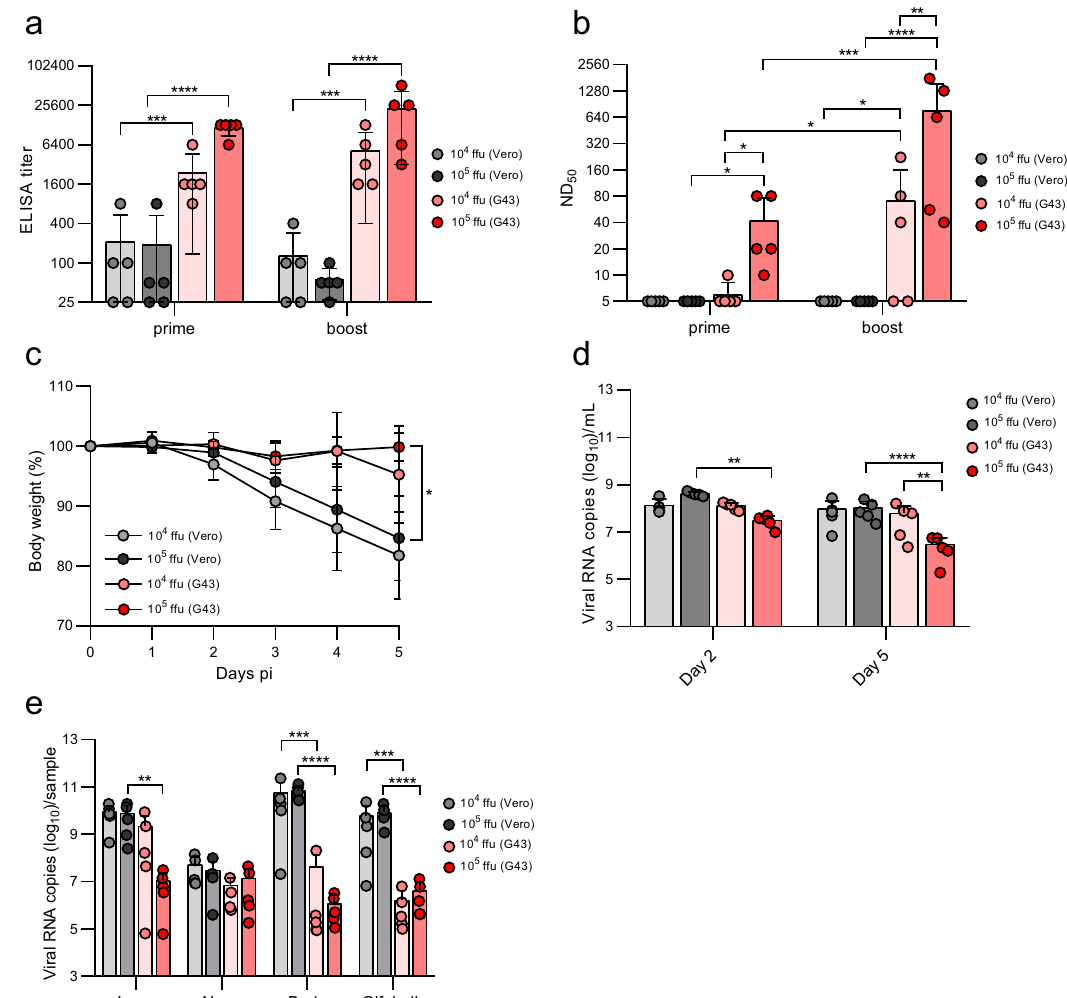
Fig. 2 Comparison of ACE2-dependent and -independent immunization. K18-hACE2 mice were immunized (i.m.) with either 10 4 or 10 5 focus-forming units (ffu) of the VSV* Δ G-S Δ 21 vector vaccine which was produced on either Vero E6 or BHK-G43 cells. a Detection of spike- speci fi c serum antibodies by ELISA 3 weeks after the fi rst (prime) and 3 weeks after the second (boost) immunization. b Determination of the virus neutralization dose 50% (ND 50 ) in serum of immunized mice. c Determination of body weight of immunized mice following nasal infection with 10 5 pfu of SARS-CoV-2-S D614G . d , e Determination of virus load by RT-qPCR ( d ) in oropharyngeal swab samples collected at days 2 and 5 pi and ( e ) in the indicated organs prepared from the euthanized animals at day 5 pi. Mean values and standard deviations for n = 5 mice per group are shown. Statistical analysis was performed using the two-way ANOVA with either Tukey ’ s or Sidak ’ s multiple comparison test (* p < 0.05; ** p < 0.005; *** p < 0.0005; **** p <